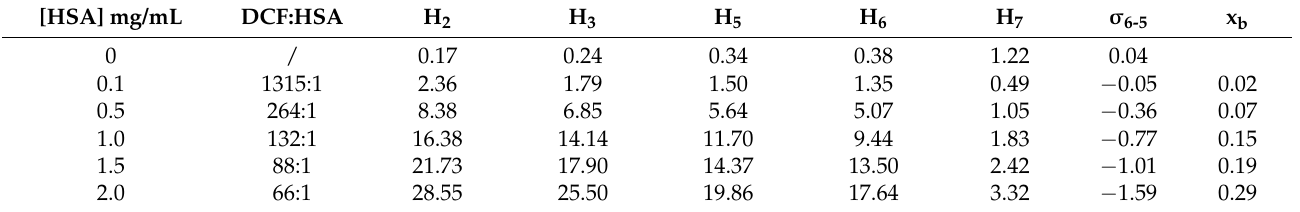
Table 2. 1 H mono-selective relaxation rates R 1ms (s −1 ) (600 MHz, 25 °C, D 2 O, pH = 7.4) of some protons of DCF (2 mM) in its free state; normalized mono- selective relaxation rates (ΔR 1ms /R f , ΔR 1ms = R obs − R f ) of DCF protons in mixtures with HSA at different molar ratios; cross- relaxation rate (σ ij , s −1 ) cal- culated for proton pair H 6 -H 5 and corresponding bound molar fraction (x b ).